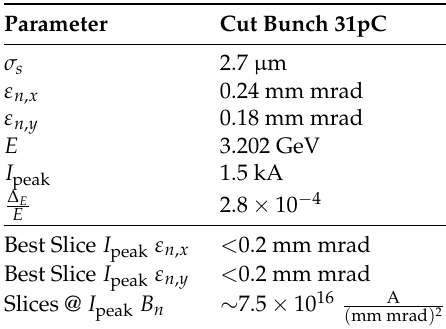
Figure 5. Slice analysis of the current distribution and of the emittance for both the transverse planes. In red the maximum acceptable emittance value, set at the beginning of this study Table 5. S2E final beam parameters relative to the most populated region of the bunch, representing the 62% of the whole bunch